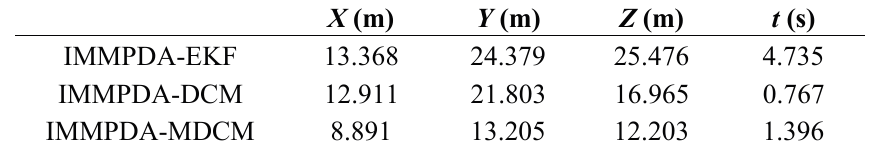
Figure 8. The comparison of position error in z direction. Table 2. The RMSE and runtime comparison of three different algorithms. X